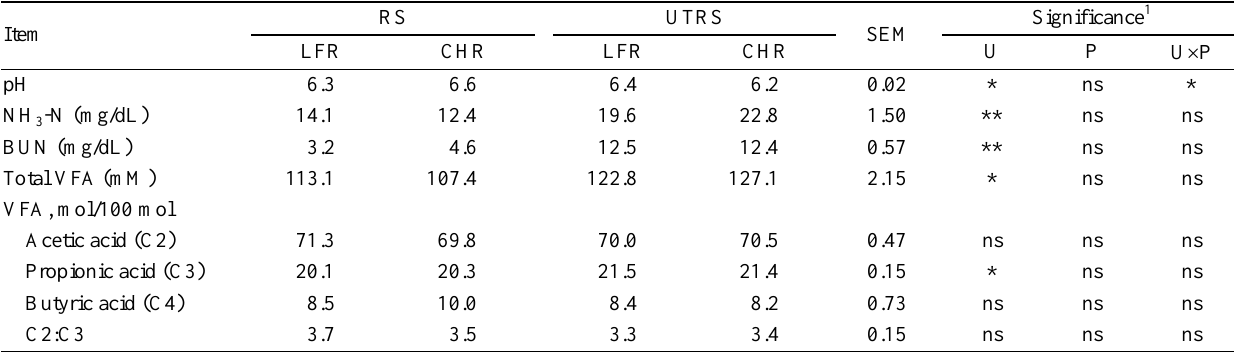
Table 3. Effect of physical form and urea treatment of rice straw on rumen fermentation and BUN in dairy steers